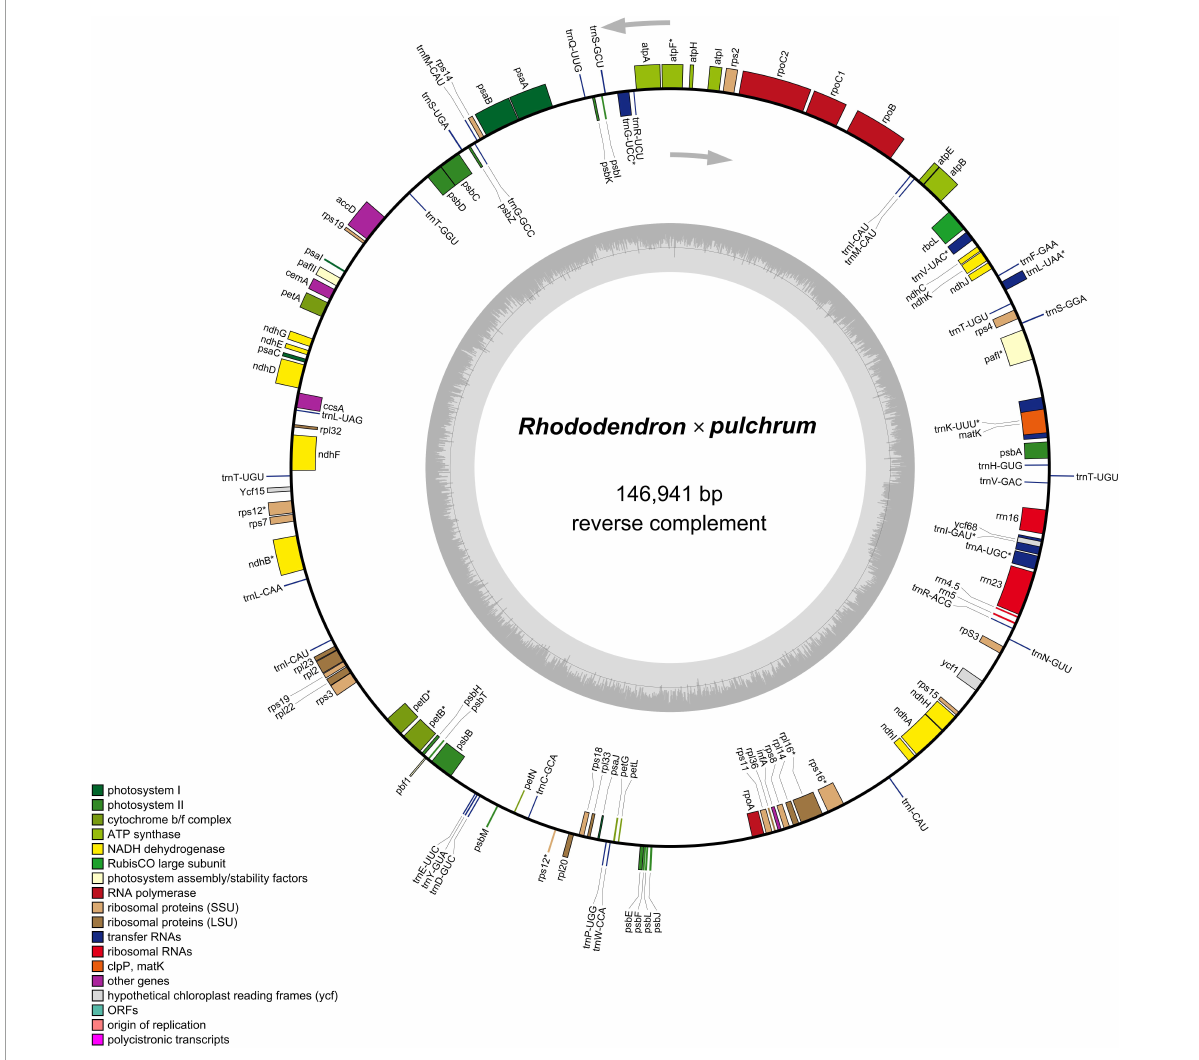
FIGURE5 Gene map of the Rhododendron × pulchrum chloroplast genome. (Genes residing in the inside and outside of the outer circle are in the forward and reverse directions, respectively. The dark and light gray bars in the inner circle denote the G + C and A + T contents,